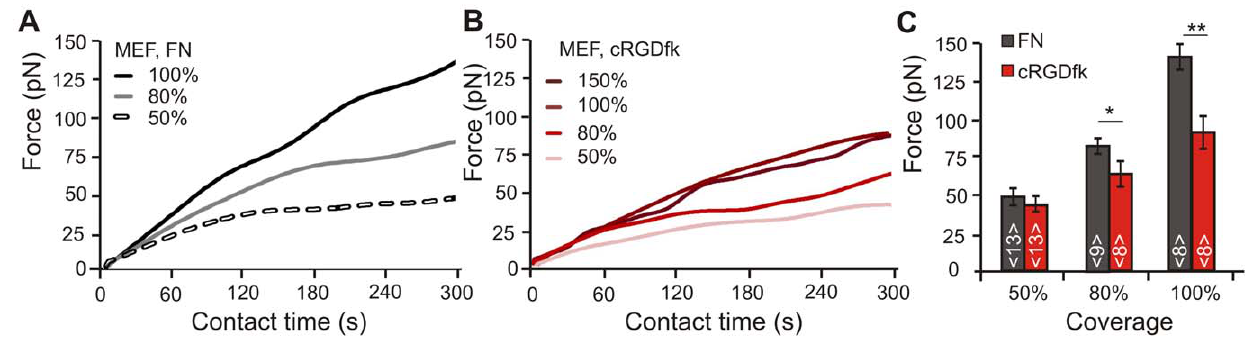
Figure 2. Dependence of cellular traction forces on ligand density. A) and B) Averaged force-time curves of cellular traction development with different coating densities of fibronectin (FN) or cRGDfk on 4.5 m m beads (averaged force-time curves including the s.e.m. for each considered ligand density are shown in Fig. S3) Cellular forces increase proportionally to the amount of ligand. C) Traction forces after 5 minutes observation time for FN or cRGDfk beads. Force exertion to FN beads is consistently higher as compared to cRGD beads (N=5 for FN and for cRGDfk beads, n=8– 13 cells).